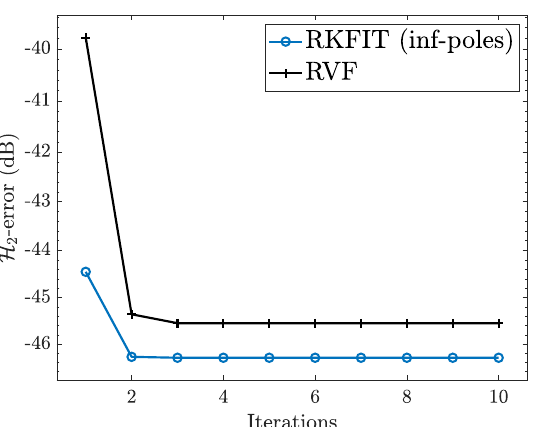
Figure 6. H 2 -error per iteration comparison between RKFIT and RVF algorithms of Section